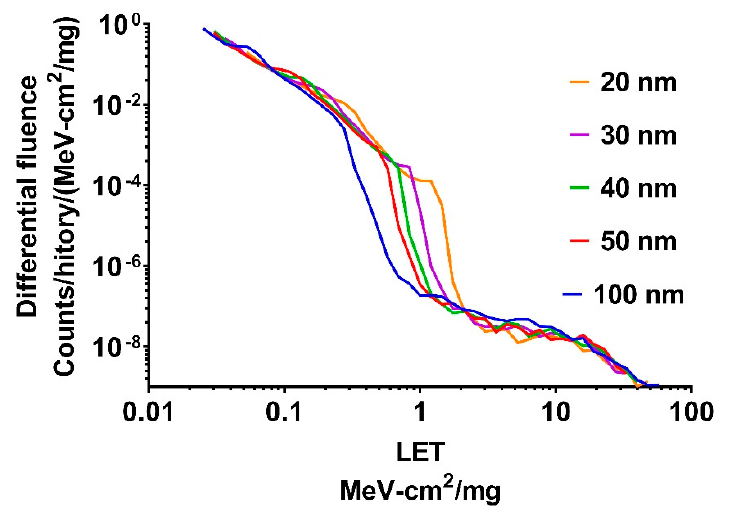
Figure 4. Lineal energy spectra of different sensitive volumes in silicon irradiated by a 200 MeV proton beam (log y scale).